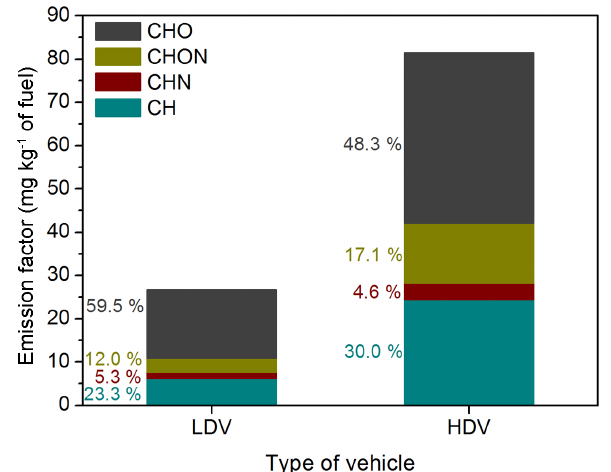
Figure 5. Scatter plot of atomic ratios O / C and H / C (van Krev- elen diagram) of TD-PTR-MS data for measurements in the TRA and TJQ tunnels that have been corrected for ambient background. The red marker represents average H / C and O / C values from am- bient aerosol samples (collected in São Paulo, between August and September 2012) that were also analyzed with TD-PTR-MS (un- published